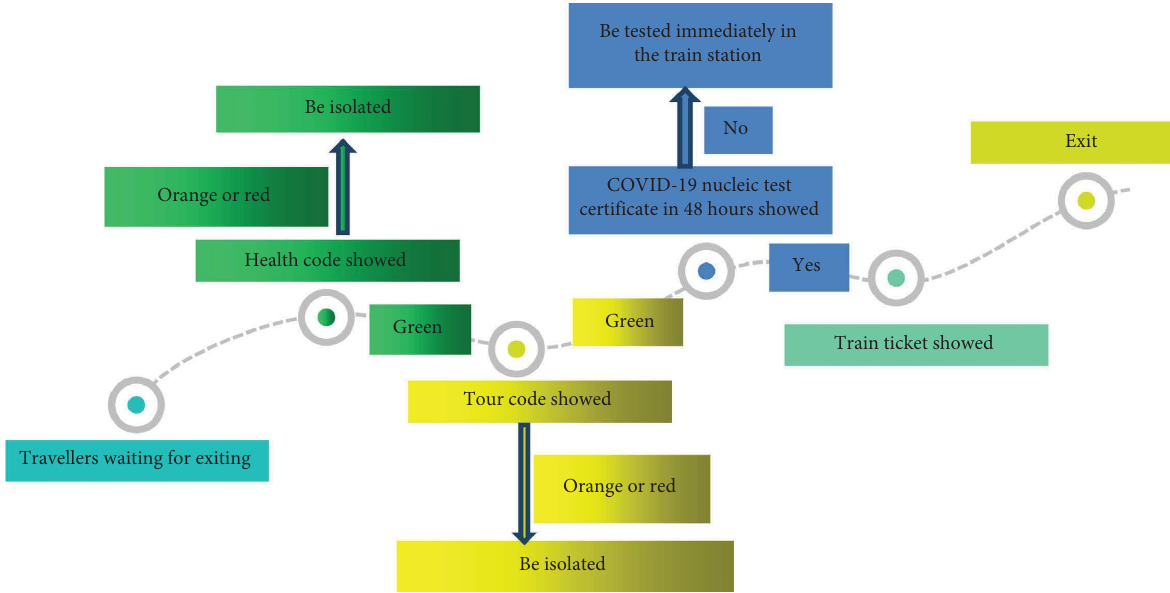
Figure 1: Flowchart for travellers exiting from the train